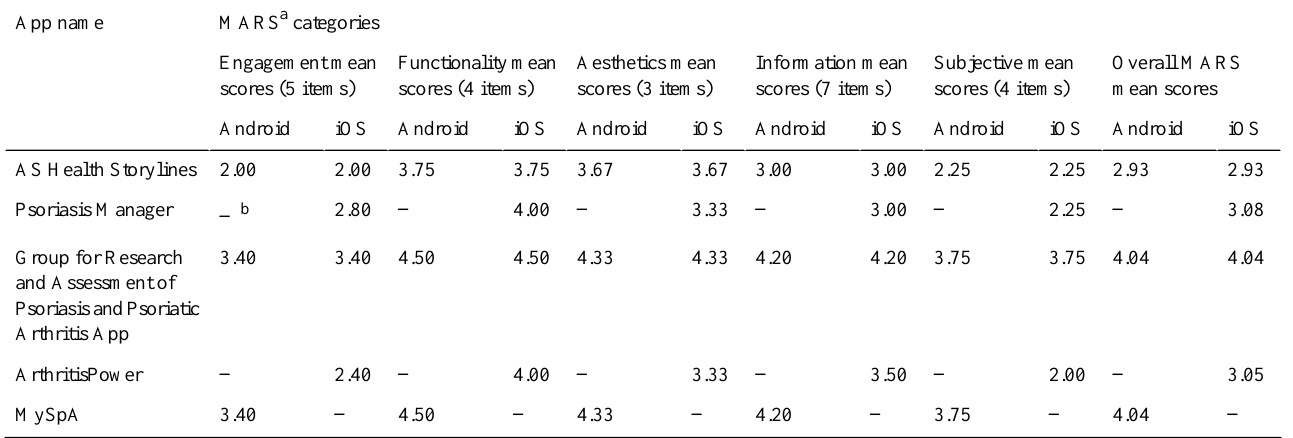
Table 5. Mean Mobile App Rating Scale ratings of included